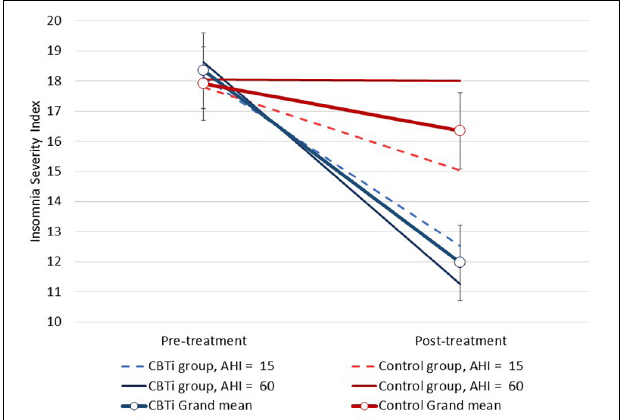
FIGURE 2 | Modeled data illustrating the effect of pre-treatment AHI, group (CBTi, control), and time (pre-treatment, post-treatment) on the Insomnia Severity Index (95%CI). Pre-treatment AHI was retained as a continuous predictor and data are plotted for pre-treatment AHI values of 15 and 60 for each group according to model intercept, slopes and interaction effects. Compared to control, higher pre-treatment AHI was associated with greater insomnia severity reduction during